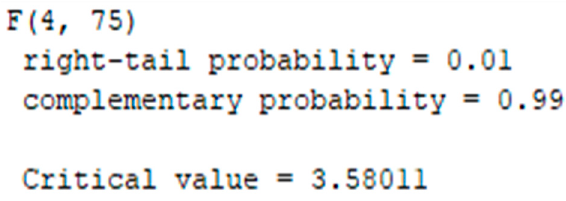
Figure 3. Compare the value of the statistic with the critical value of the corresponding Fisher distribution at a significance level of 1%.